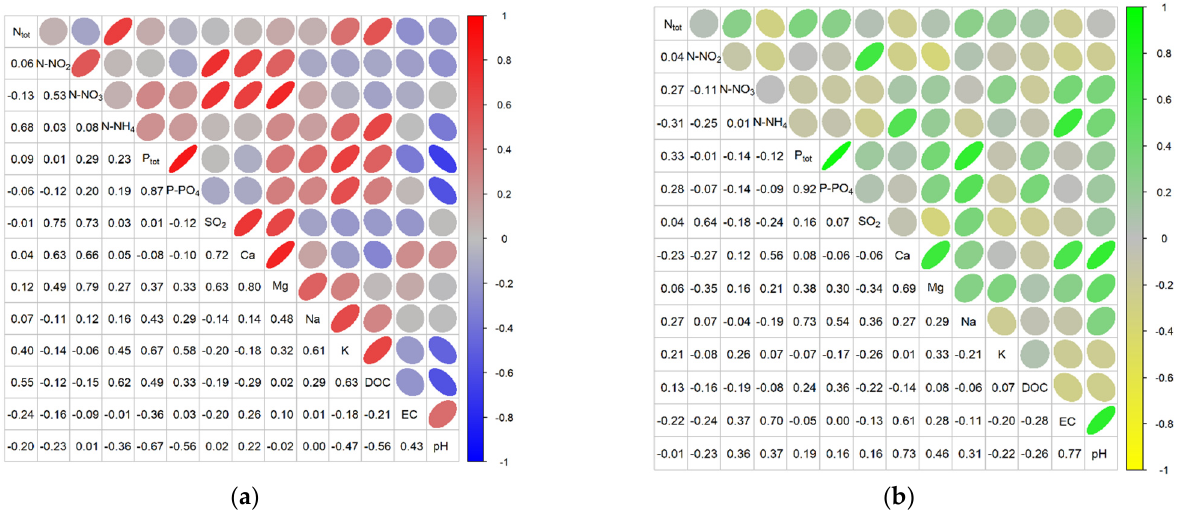
Figure 6. Correlations between physicochemical factors of peatland water as pooled data for Co- marum palustre in 2011–2013: ( a ) abundant sites, ( b ) non-abundant sites. Ellipse angulation and color intensity are proportional to the Pearson correlation coefficient: positive correlations are shown in red/green and negative correlations in blue/yellow.